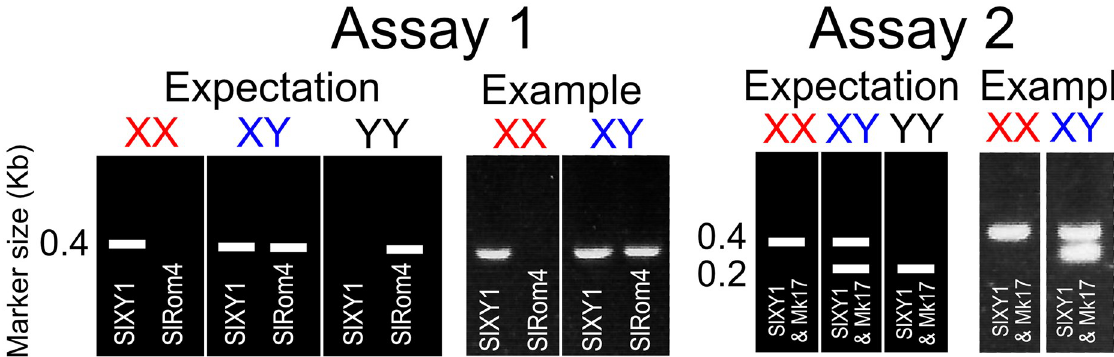
Fig 2. Expected results from the two assays used to determine whether the plants contained X and/or Y chromosomes. An example gel picture is illustrated next to each expectation.